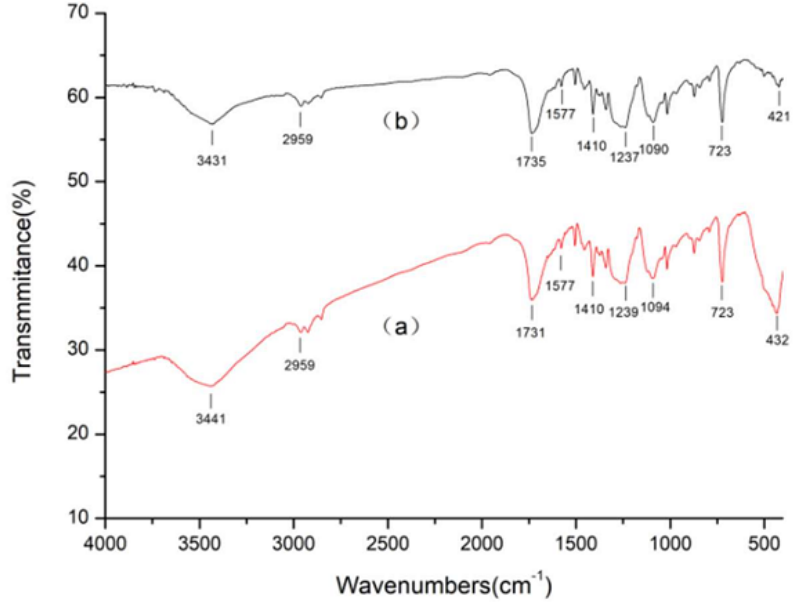
Figure 5. FTIR spectra of ( a ) ZnO coated polyester nonwoven (2#); ( b ) ZnO/Ag composite coated polyester nowoven